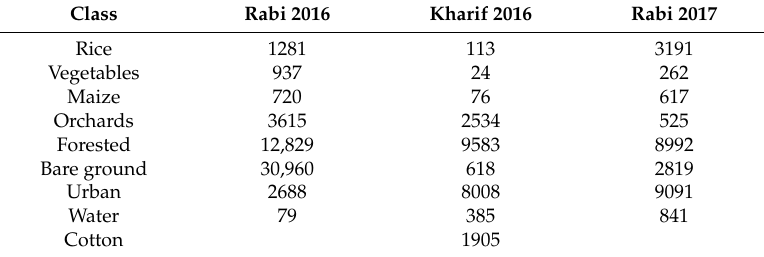
Table 2. Number of training and validation samples derived from the field data in Rabi 2016 (December to March 2016), Kharif 2016 (July to November 2016), and Rabi 2017, at 10-m resolution. This number is divided by four at 20-m